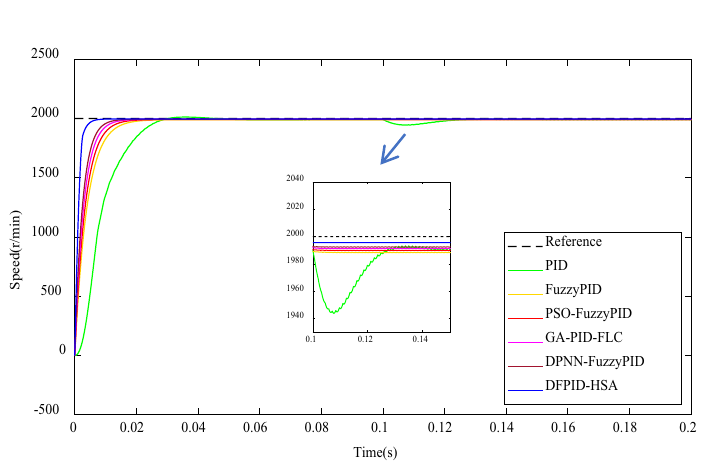
Figure 12. The comparison of speed response under the fixed load